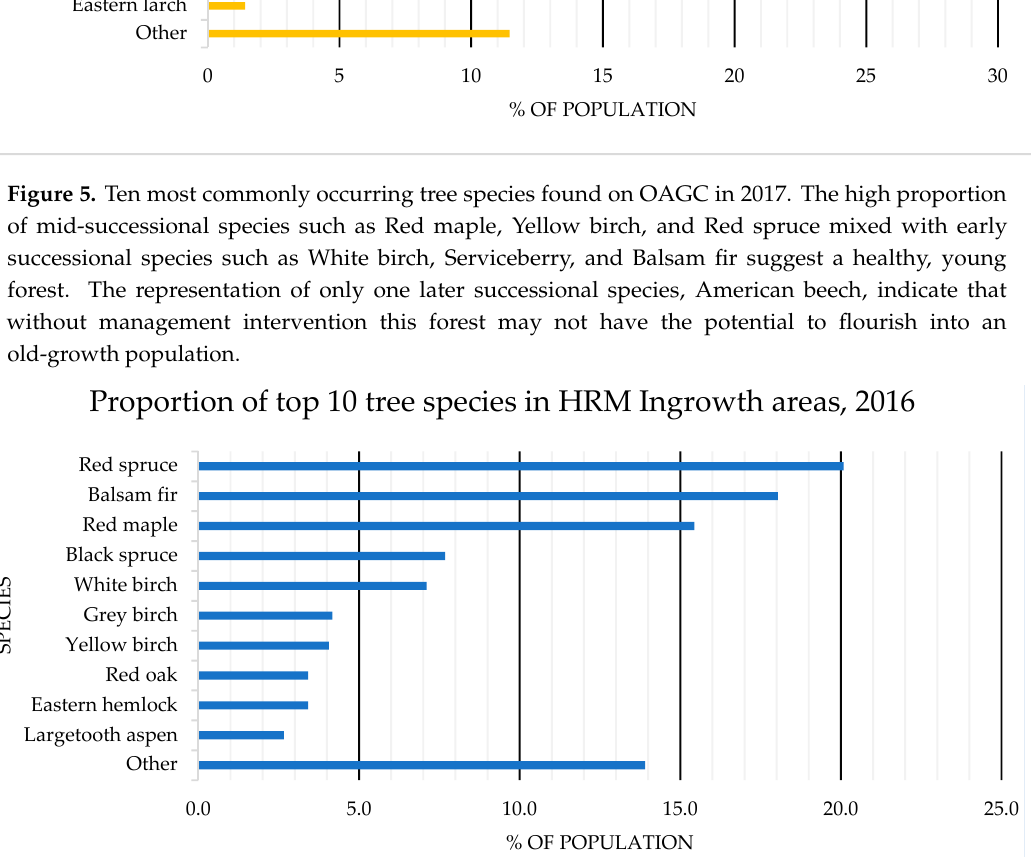
Figure 6. Ten most commonly occurring tree species found in HRM ingrowth areas (Data: 11). With a high proportion of early successional species such as Balsam fir, White birch, and Grey birch, a smaller proportion of mid-successional species such as Red spruce and Yellow birch, and some late-successional species such as Red oak and Eastern hemlock, this species distribution is demonstrative of a healthy Acadian forest.